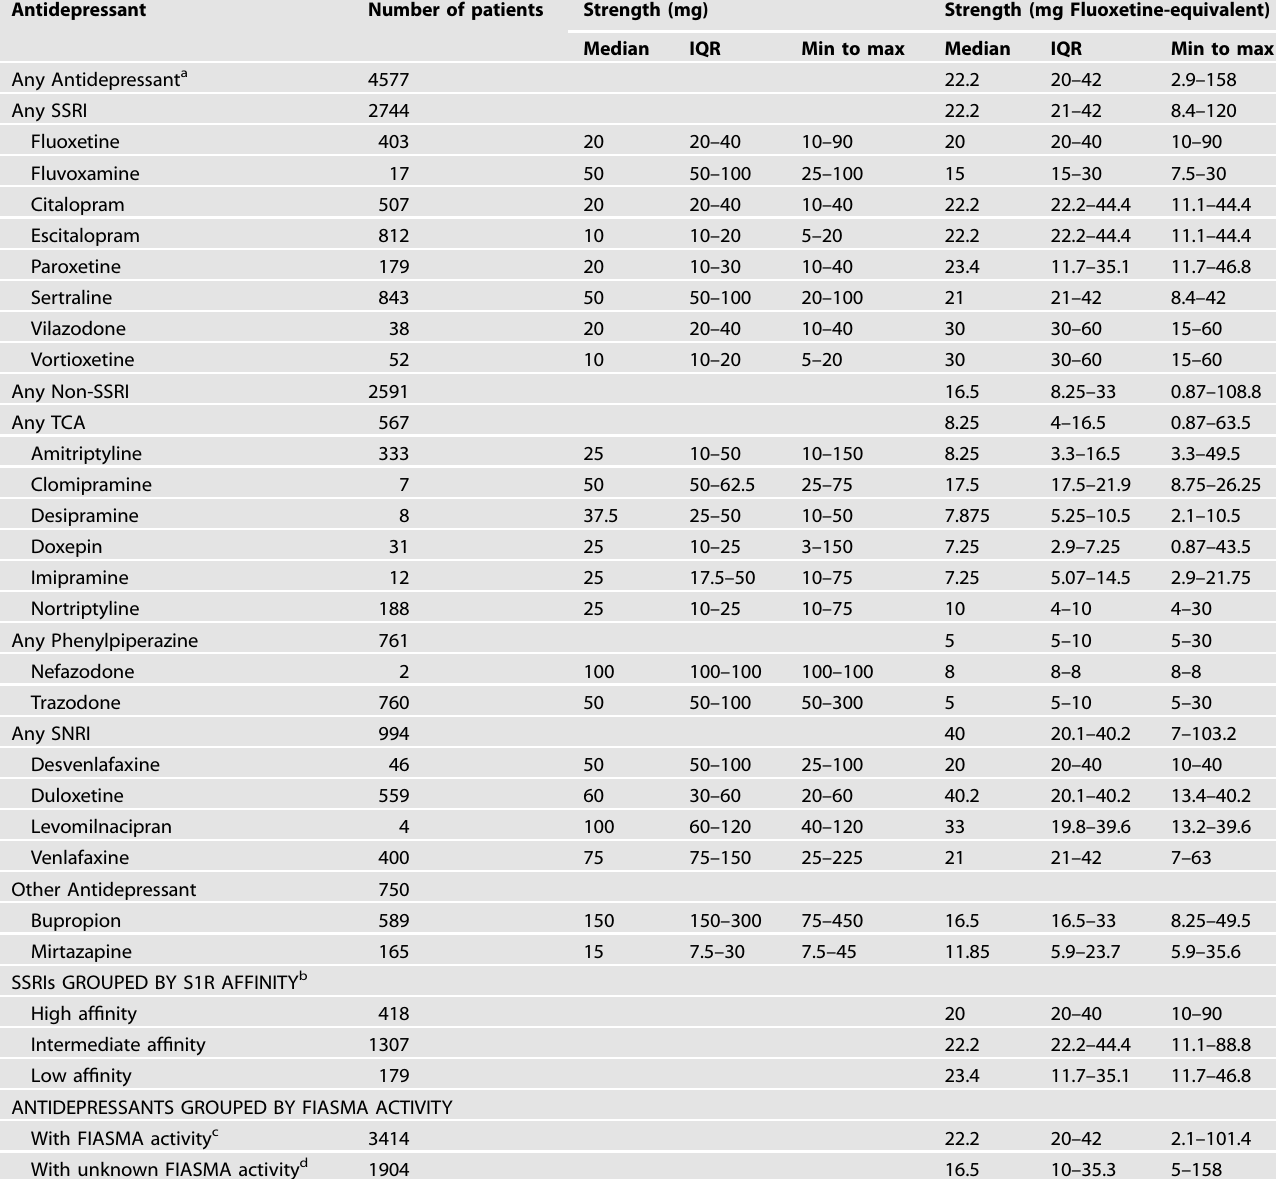
Table 2. Antidepressants used and range of formulation